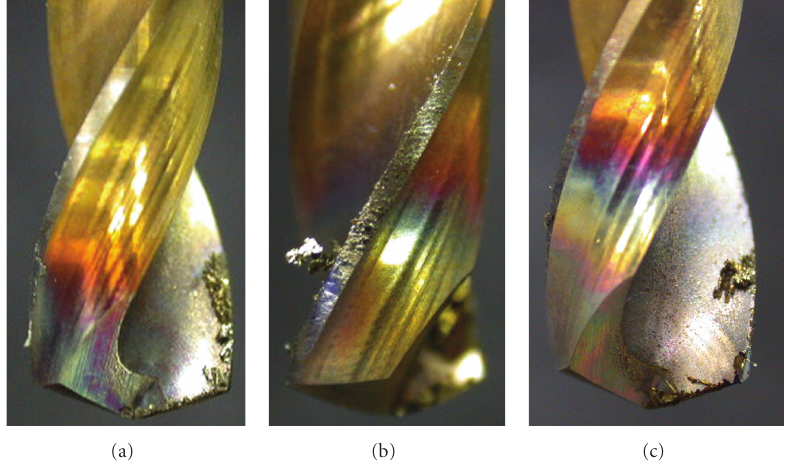
Figure 4: Evolution of the drilling tool after (a) eight, (b) ten, and (c) fourteen drills at 30 m/min.